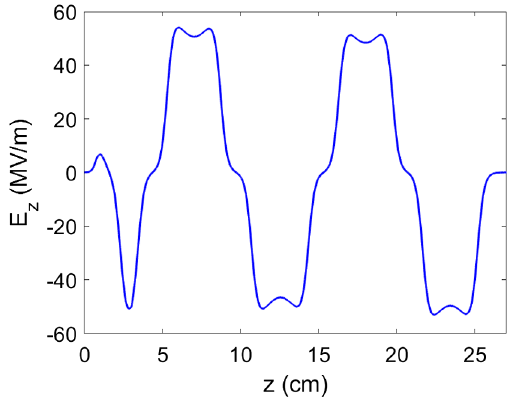
FIG. 14. The final cavity geometry showing the electric field map at 1 J of stored energy. Part (a) features side coupled cells and (b) features rf coupler.